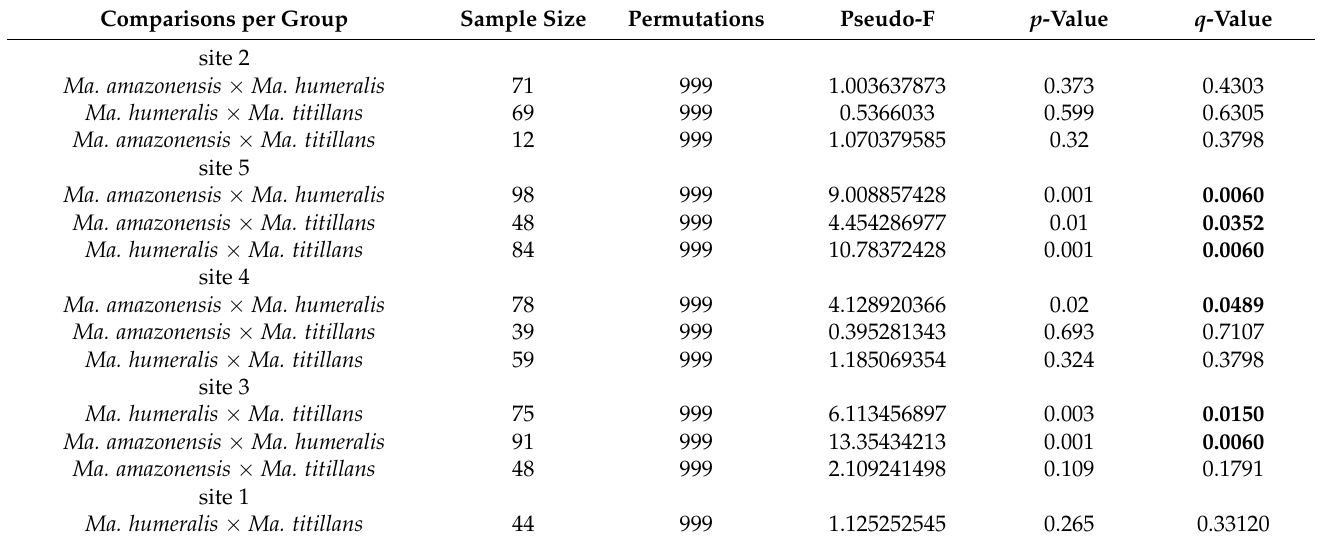
Table 2. Results of PERMANOVA pairwise distances multivariate analysis. Variance of pairwise distance comparisons, according to Mansonia species at each collection point. Values in bold denote statiscrical significance at the q < 0.05 level.